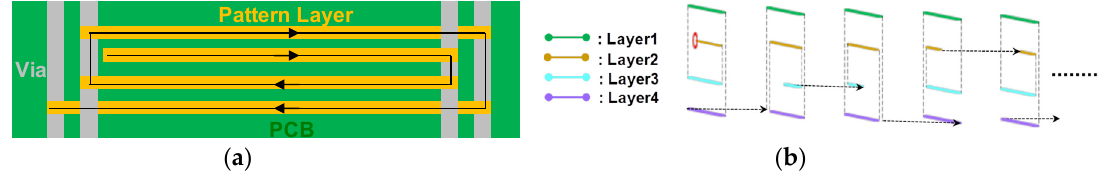
Figure 3. Spiral pattern pick-up coil PCB configuration with winding direction: ( a ) Cross-section view; ( b ) oblique view.